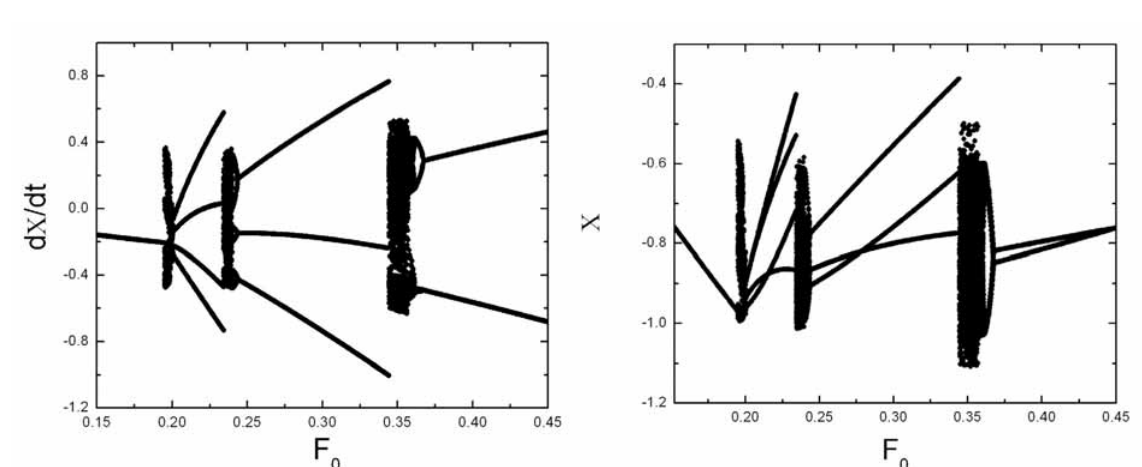
Fig. 11. Bifurcation